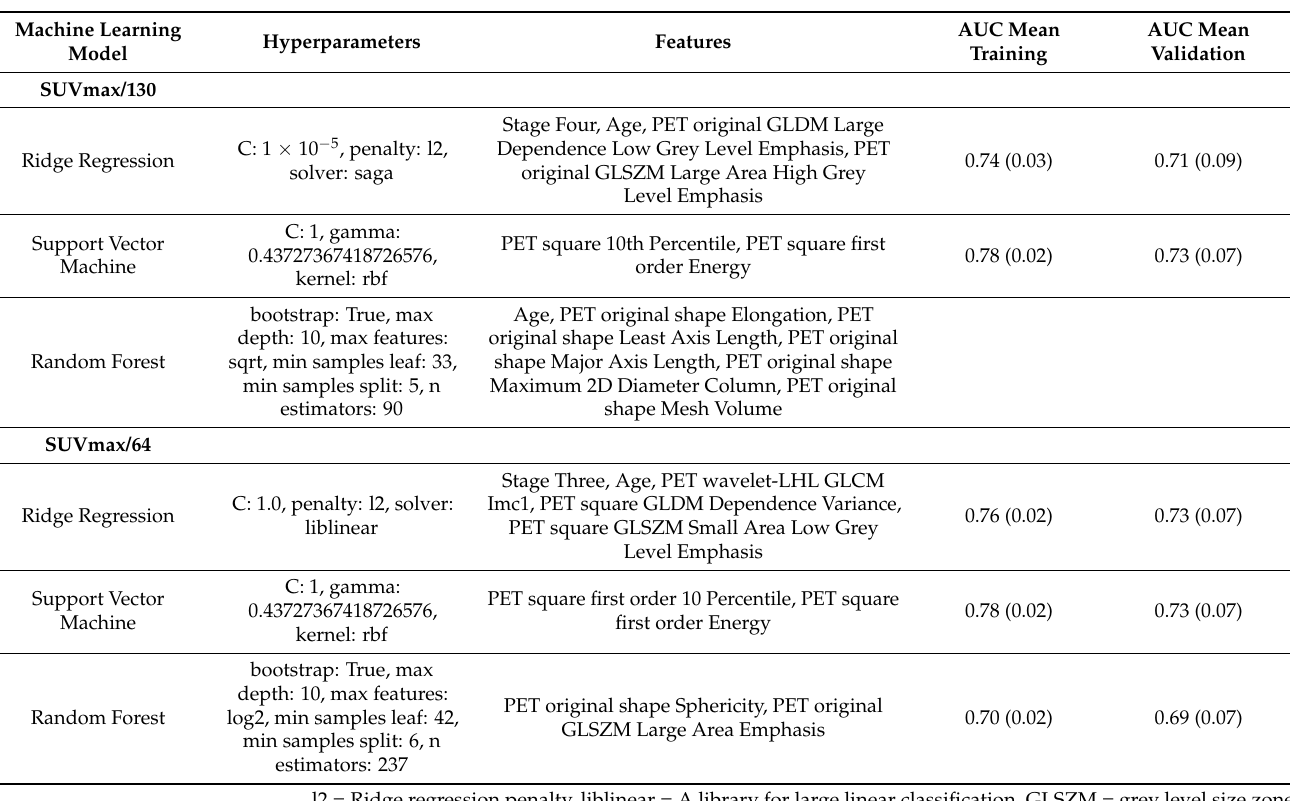
Table 4. Mean training and validation scores for the best performing machine learning models using the 1.5 times mean liver SUV thresholding segmentation